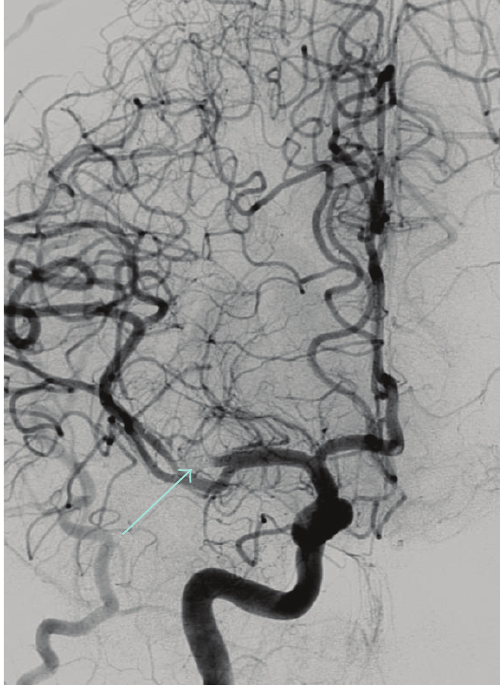
Figure 2: Anteroposterior view of the right internal carotid angiogram after endovascular treatment showing occlusion of the parent artery by coils (arrow) and complete exclusion of the